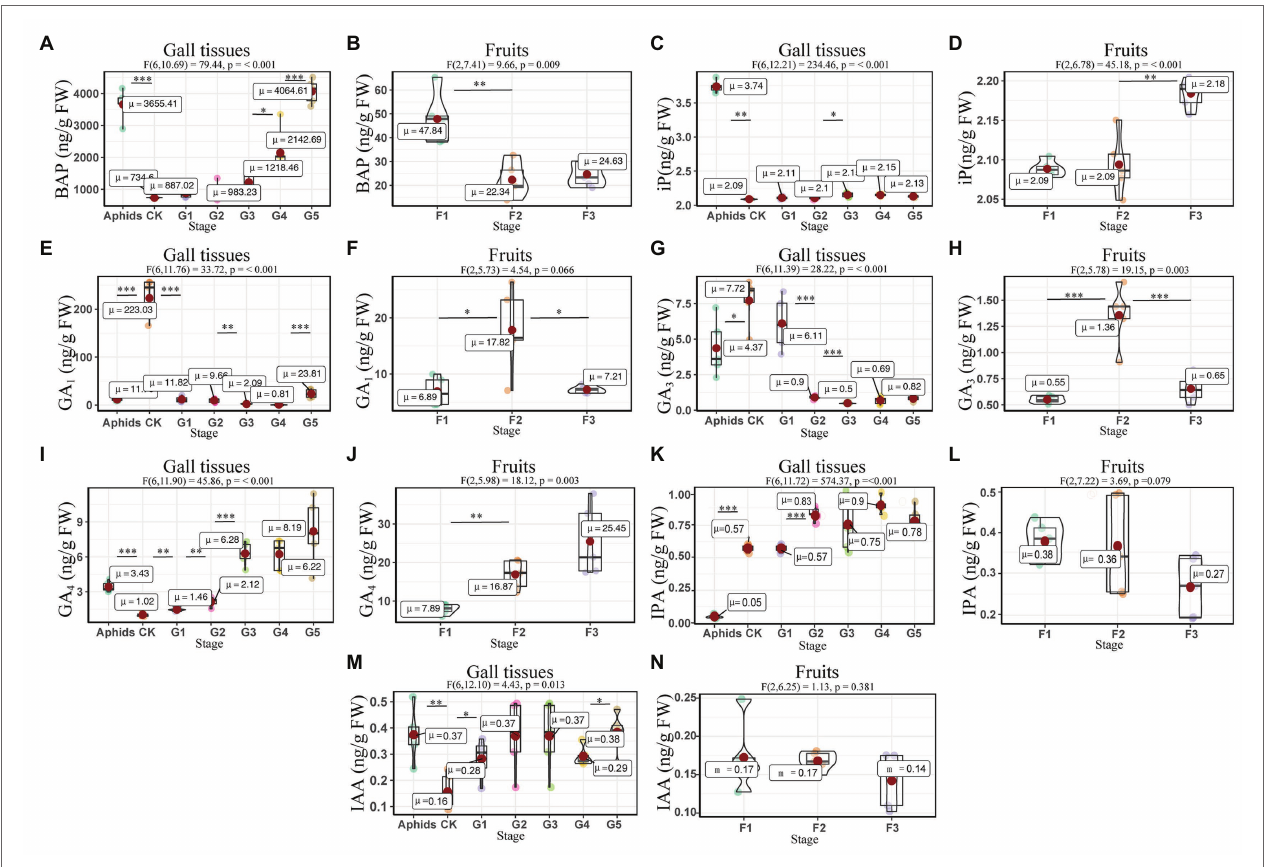
FIGURE 4 | Quantitative analysis of growth related phytohormones in the larch adelgids, gall tissues, and cones (fruits) of P. koraiensis . Quantitative analysis of 6-benzylaminopurine (BAP) in larch adelgids, gall tissues, normal branches (A) , and cones (B) . The level of 6-( γ , γ -dimethylallylamino) purine (iP) in gall tissues and normal branches (C) and cones (D) . The level of GA 1 in larch adelgids, gall tissues, and normal branches (E) and cones (F) . Quantitative analyses of GA 3 and GA 4 in larch adelgids, gall tissues, and normal branches ( G and I ), and cones ( H and J ), respectively. The Levels of IPA and IAA in larch adelgids, gall tissues, and normal branches ( K and M ), and cones ( L and N ), respectively. CK = normal branches. Data are presented in nanograms per gram of fresh weight (ng/g FW), and boxplots display the minimum, first quartile, median, third quartile, and maximum for each stage in the given tissues. G1–G5 represent the different developmental stages of gall tissues and F1–F3 represent different developmental stages of cones. Red point = mean value. Horizontal black line inside the box = median value. The shape of the boxplot indicates the distribution of results. Mean differences were compared using t -tests. * Denotes that the value of p is less than 0.05. ** Denotes that the value of p is less than 0.01. *** Denotes that the value of p is less than 0.001. These results shown represent the average ± SD and performed one-way ANOVA test among three or more groups. ω p 2 = partial omega